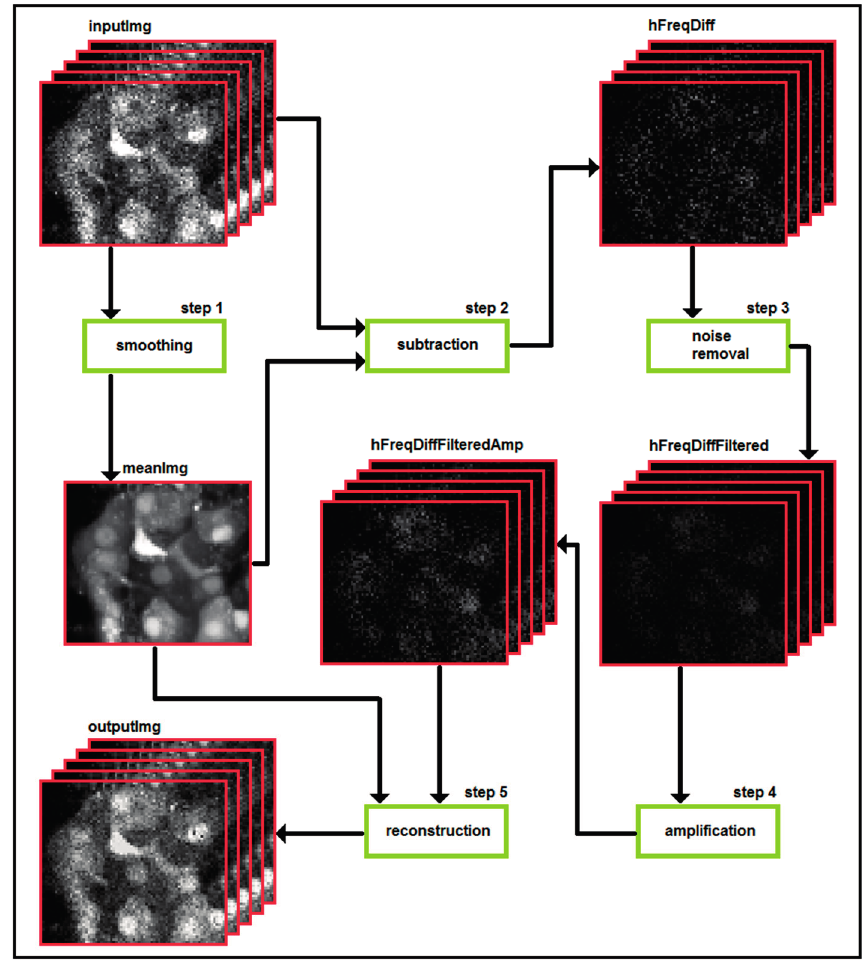
Figure 4. Flowchart representing the algorithm used to pre-process data obtained from confocal imaging of [Ca 2+ ] i and MP in pancreas tissue slices. See text for detailed description of the